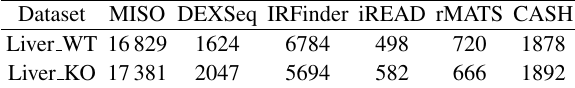
Fig. 3 Venn and UpSet diagram showing the IR intersection of six methods on the Upf2 knockout sample. Table 4 The numbers of IRs detected on the Upf2 knockout mouse dataset.